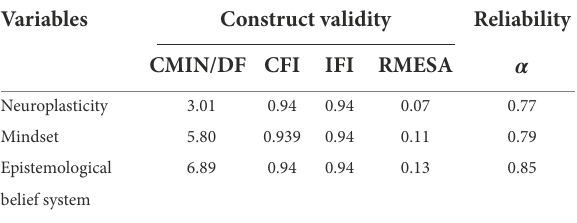
TABLE 2 Construct validity and reliability of the